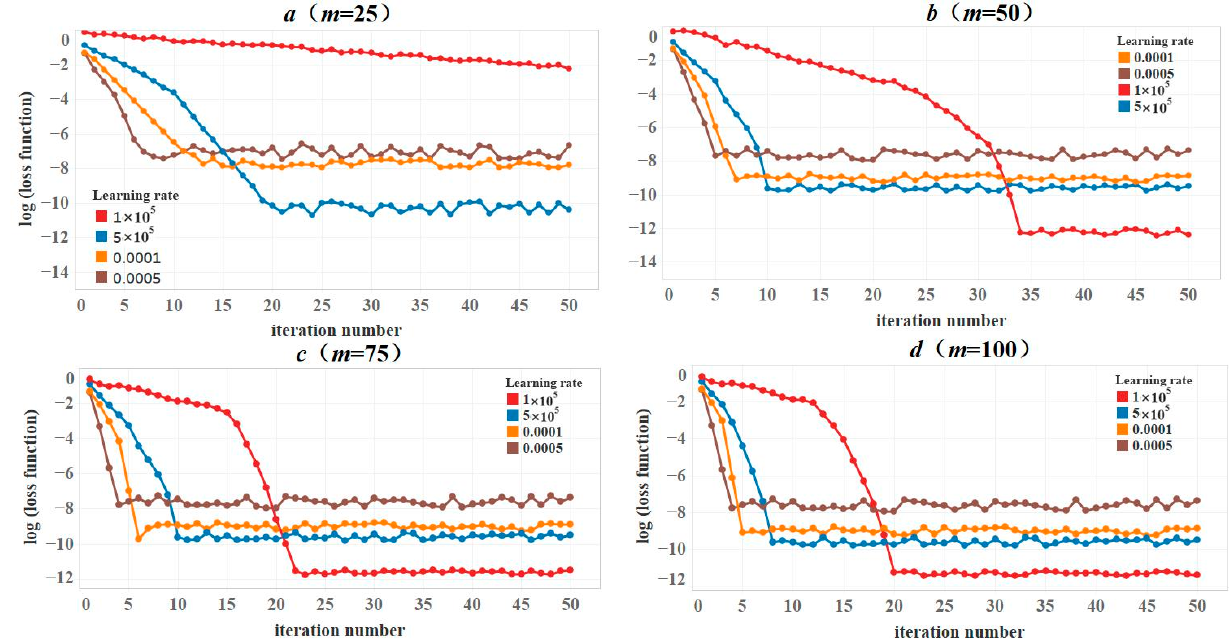
Figure 4. The changes of log ( L sparse ) with different parameters in LSTM.